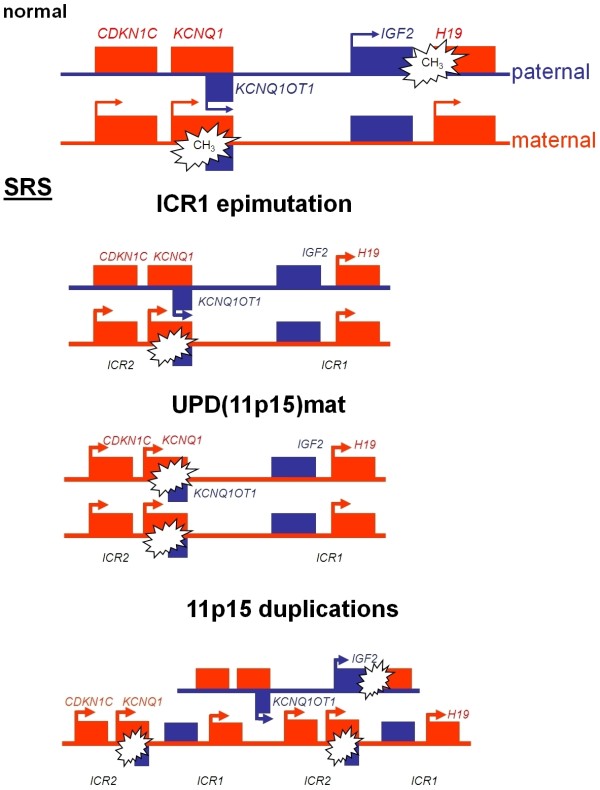
Epigenetic regulation of the two imprinting centre regions (ICR) in 11p15 and illustration of the types of (epi)mutations detectable in SRS.